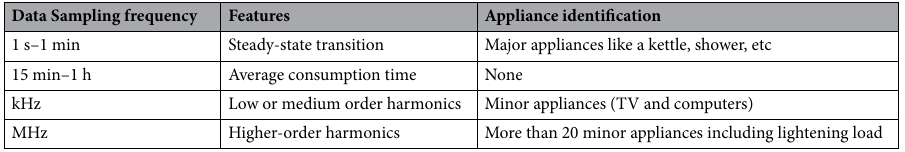
Table 1. Data sampling rate and appliance identification 31,32